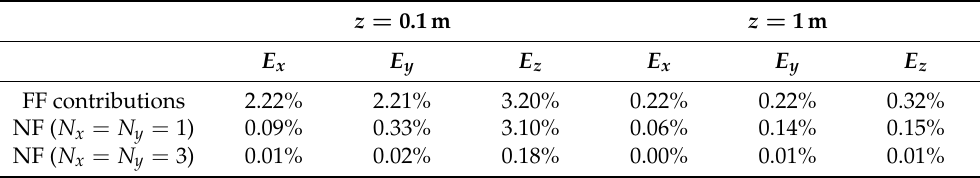
Figure 4. Comparison of the near field radiated by a center-fed transmitarray in magnitude and phase for the plane z = 0.1m generated by the model based on the superposition of far field contributions of each array element ( top row), and the near field model based on the radiation equations for N x = N y = 5 ( bottom row). The relative error between both simulations taking the bottom row as reference is 2.2% for both components of the field. Near field is plotted in the NFCS. Table 1. Relative error of the field components calculated with the different near field models when compared with the model based on the radiation equations with N x = N y = 5, which is taken as